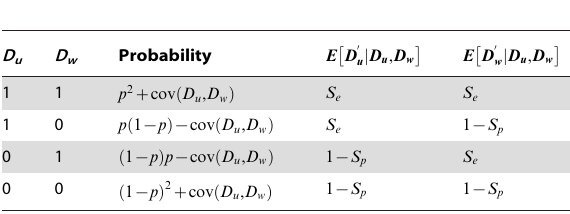
Table 2. Covariance expectations between animals with different disease classification status.